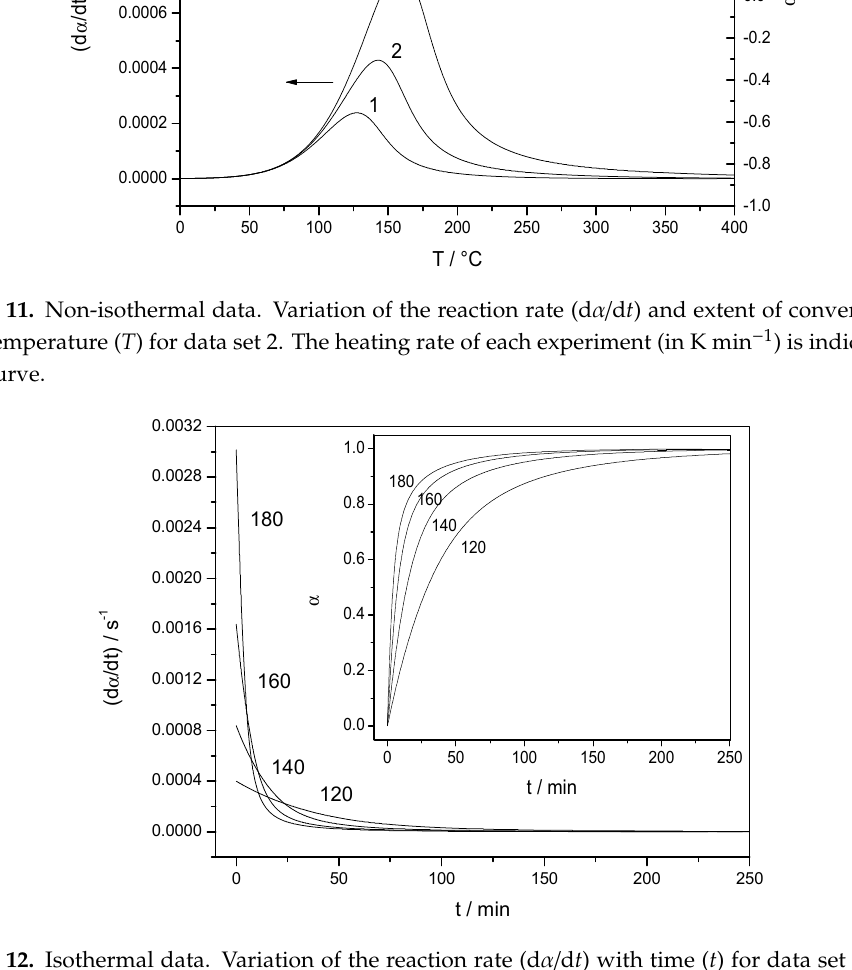
Figure 12. Isothermal data. Variation of the reaction rate (d α / d t ) with time ( t ) for data set 2. Inset: Variation of the extent of conversion ( α ) with time ( t ). The temperature of each experiment (in °C) is indicated by each curve.